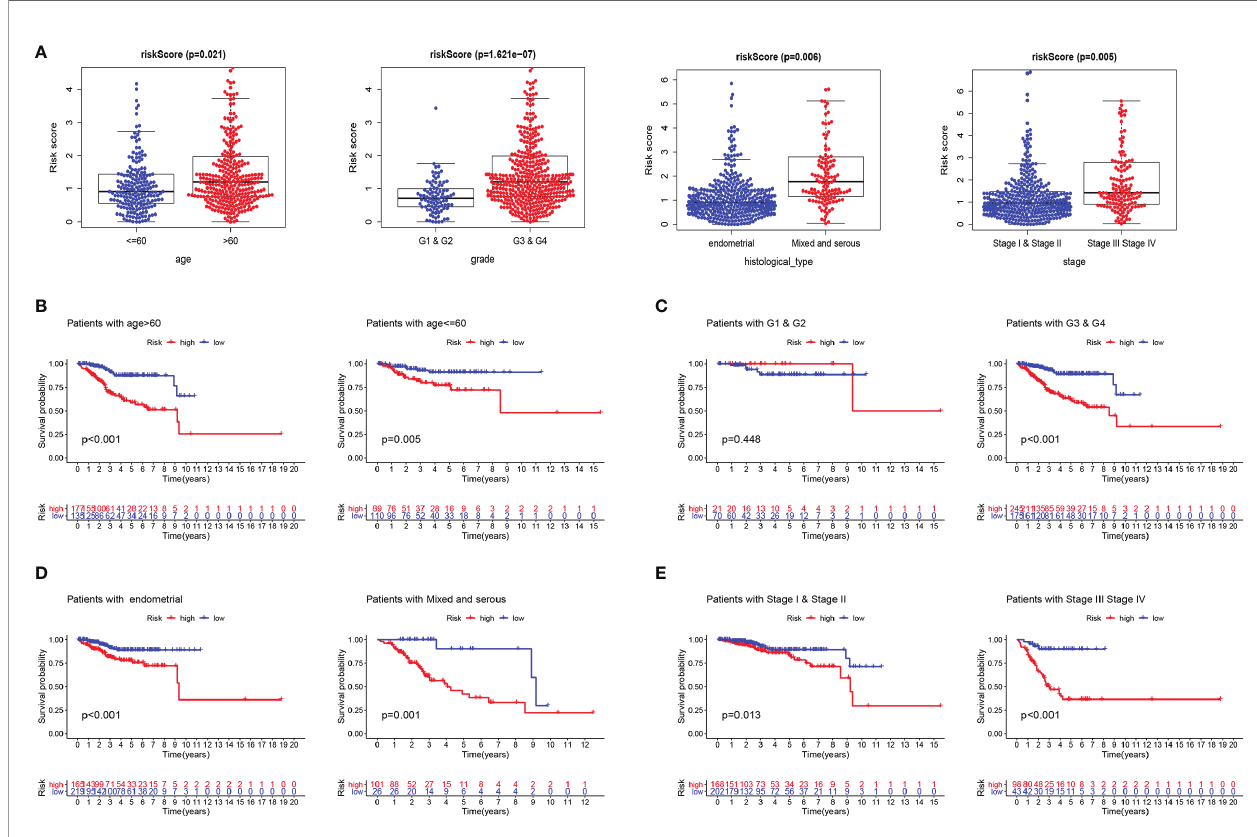
FIGURE 2 | Subgroup analysis of the prognostic value of risk score in EC patients. (A) Boxplots of the risk score in EC strati fi ed by age, grade, histological_type, and stage. Prognostic value of risk score in patients with different ages (B) , different grades (C) , different histological_types (D) , and different stages (E) . EC, endometrial